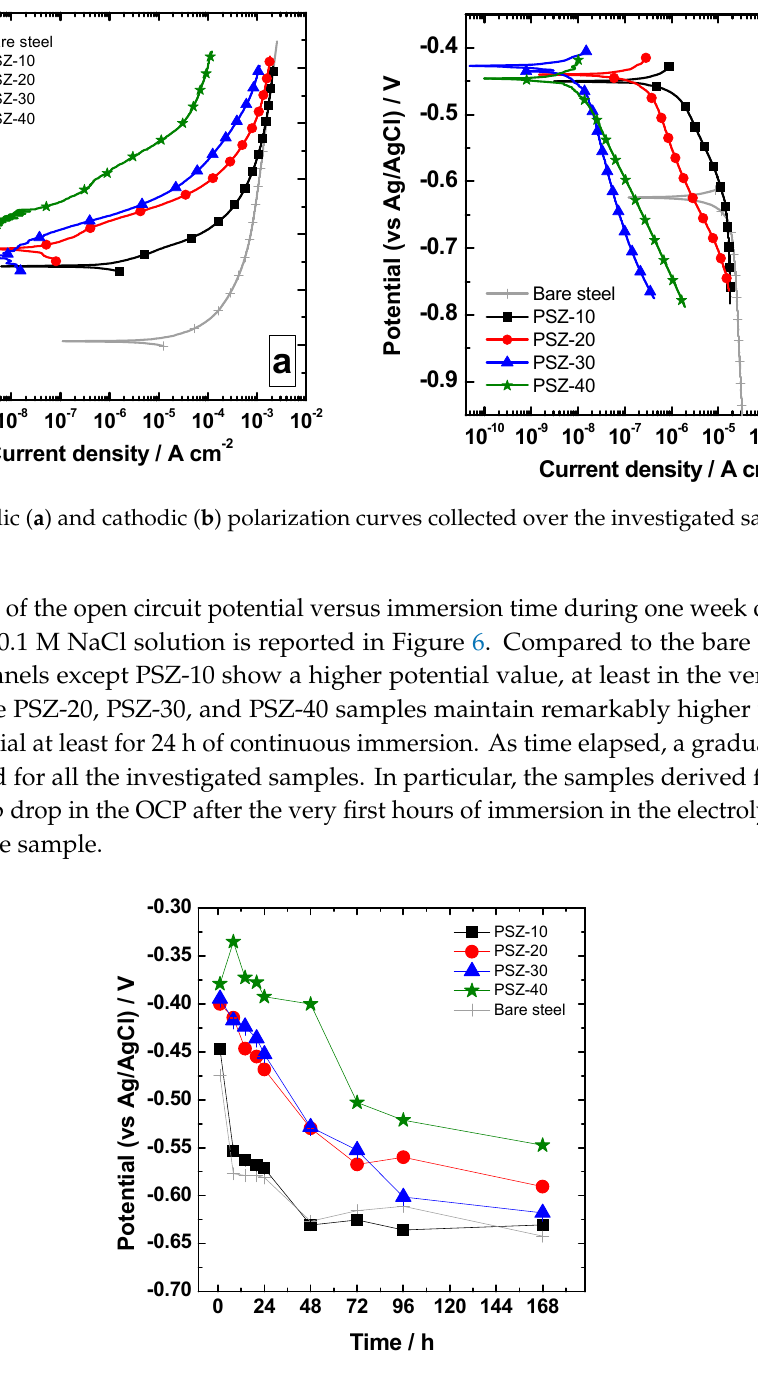
Figure 6. Evolution with immersion time in 0.1 M NaCl of the open circuit potential (OCP).